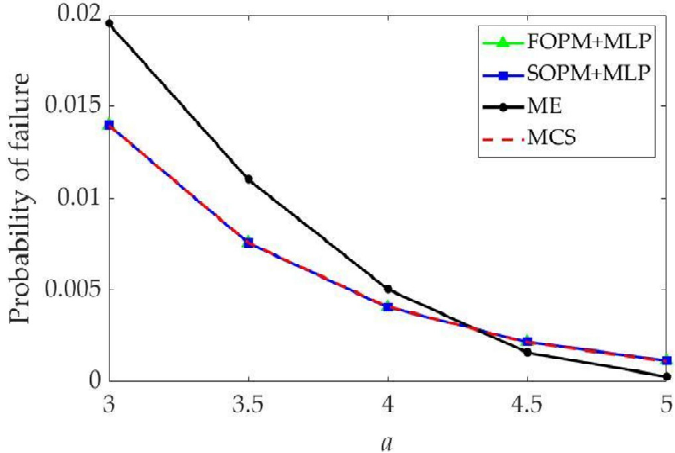
FOPM + MLP and SOPM + MLP compared with ME is that their accuracy in approximating the probability distribution based on cubic normal transformation is higher than that of ME, given the same first four moments of the performance function in this example. the same first four moments of the performance function in this example.